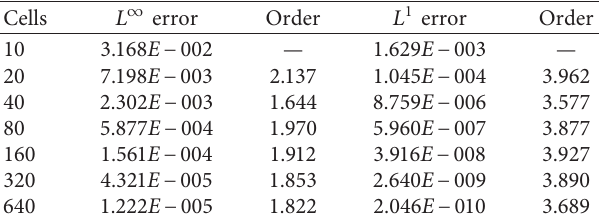
Table 3: Example 2, numerical errors and orders of convergence at t � 1. Cells L ∞ error